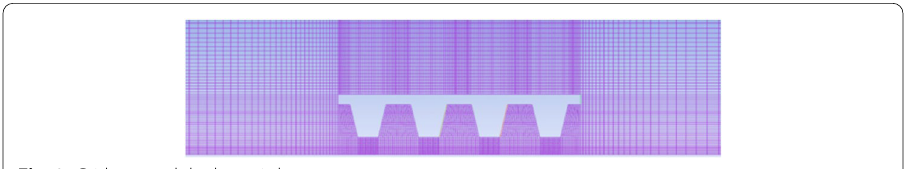
Fig. 2 Grids around the box-girder